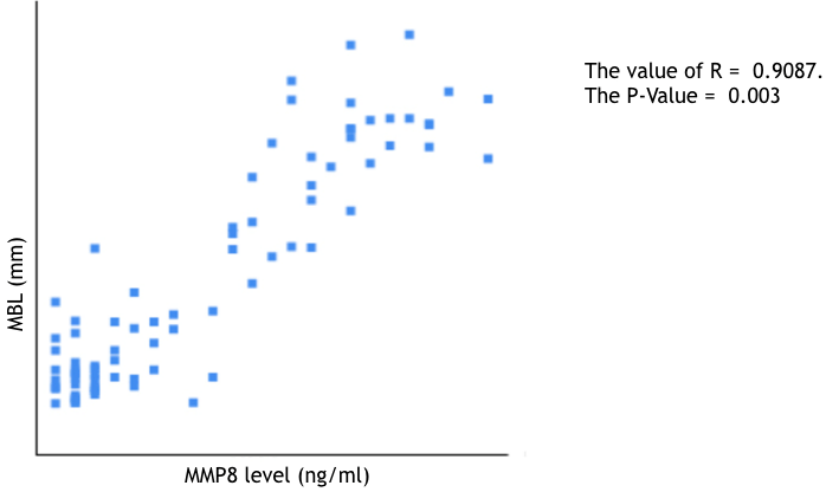
Figure 6. Pearson correlation between MBL and MMP-8 concentration at T6.